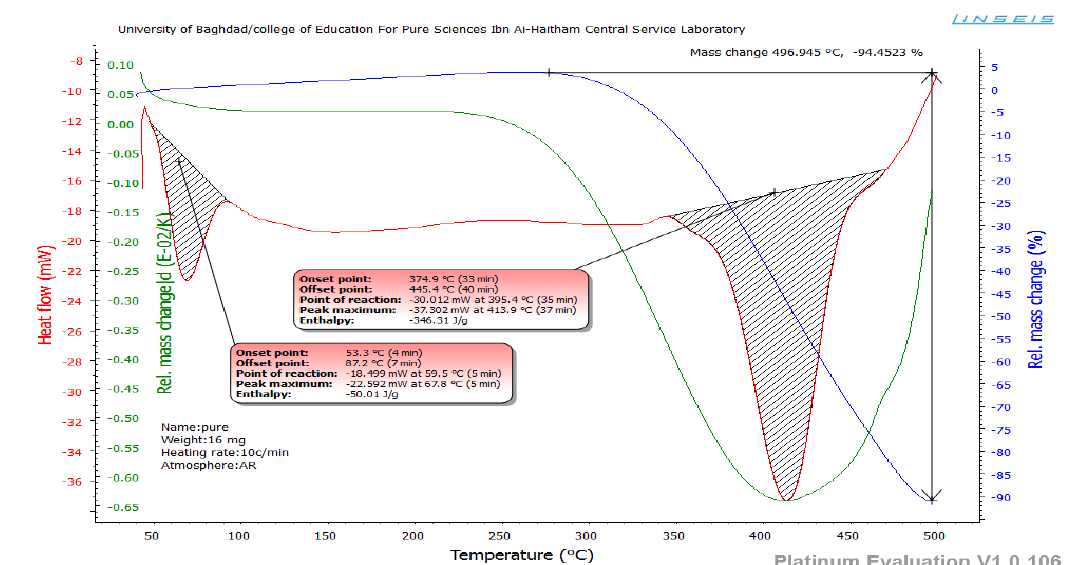
Fig.5: Thermal Gravimetric Analysis of pure